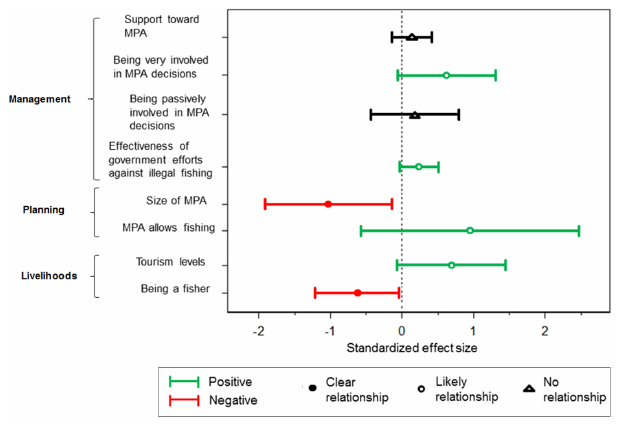
Fig. 1 . Relationship between marine protected area (MPA) and individual variables and perceived levels of compliance. Circles and triangles represent the estimated effect of each variable. Bars represent 95% confidence intervals. Positive estimates are shown in green, negative are in red, and no effect is black. Filled red circles indicate a clear negative relationship to compliance; open green circles represent likely positive relationships to compliance (≥80% of the confidence intervals in a positive direction).